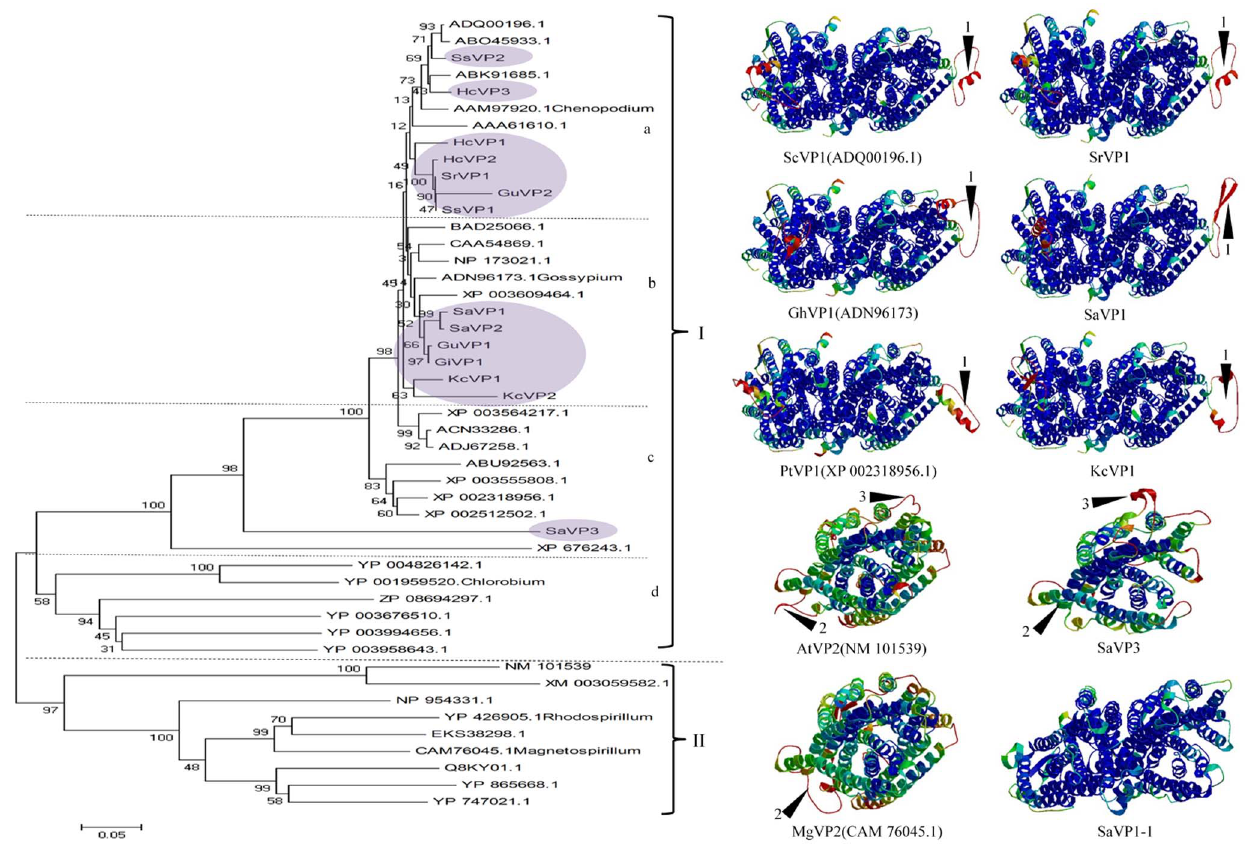
Figure 5. Phylogenetic tree of H + -PPase sequences from some representative species by NJ and a 3D structure prediction by Swiss Model. Purple indicates novel cloned H + -PPases from 7 eremophytes. The type I H + -PPases were made up of a, b, c and d subgroups. The a subgroup is made up of ScVP (ADQ00196.1), HcVP (ABO45933.1), KfVP (ABK91685.1), ChrVP (AAM97920.1), SsVP2 , HcVP3 , MtVP (XP_003609464.1), SaVP1 , SaVP2 , GuVP1 , GiVP1 , GhVP (ADN96173.1), NtVP (CAA54869.1), and AVP1 (NP_173021.1). The b subgroup includes OsVP (BAD25066.1), BvVP (AAA61610.1), HcVP 1, HcVP 2, SrVP 1, SsVP 1, GuVP 2, KcVP1 and KcVP2 . The c subgroup is formed by BdVP (XP_003564217.1), ZmVP (ACN33286.1), SbVP (ADJ67258.1), ZxVP (ABU92563.1), GmVP (XP_003555808.1), PtVP (XP_002318956.1), RcVP (XP_002512502.1). And the d is formed by ChlrVP (XP_001694682.1), SaVP3, PbVP (XP_676243.1), RhmVP (YP_004826142.1), ChpVP (YP_001959520.1), ThmVP (YP_003676510.1), ElVP (YP_003958643.1), HhVP (YP_003994656.1), FvVP (ZP_08694297.1). The type II H + -PPase includes AVP2 (NM_101539), MpVP (XM_003059582.1), RhrVP (YP_426905.1), MgVP (CAM76045.1), NeVP (YP_747021.1), GsVP (NP_954331.1), AbVP (EKS38298.1), RhpVP (Q8KY01.1), and MmVP (YP_865668.1). 3D structures including type I H + -PPase ScVP1 (ADQ00196.1, Suaeda corniculata ), OsVP1 (BAD25066.1, Oryza sativa ), ChrVP1 (XP_001694682.1, Chlamydomonas reinhardtii ), SrVP1 , SaVP1 and KcVP1 are present as homodimers. The others are monomer H + -PPase, they are AVP2 (NM_101539, Arabidopsis thaliana 2 ), SaVP3 and MgVP2 (CAM76045.1, Magnetospirillum gryphiswaldense ). The SaVP1-1 was truncated according to the sequence of SaVP3 . Number 1, 2 and 3 and black arrows in the 3D structure showed different regions. black arrows in Figure 5. The structure noted with black arrow was shown as a -helix and random coil at the position 1 of type I H + -PPases from Chenopodiaceae, Oryza sativa , Chlamydomonas reinhardtii and Karelinia caspia , but it was a b -fold in the Sophora alopecuroides H + -PPase. Monomeric H + -PPases are clearly different at position 2 (Figure 5), such as a b -corner in the type II H + -PPase of A. thaliana , a random coil in Magnetospirillum gryphiswaldense , or a b -fold in Sophora alopecuroides SaVP3 . In summary, for the same protein, different species may have different protein structures.